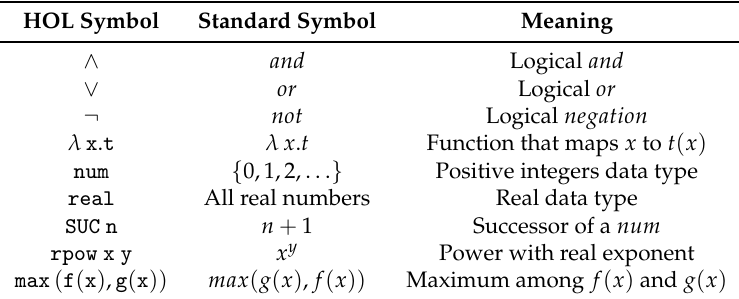
Table 2. Higher-order-logic (HOL) symbols and